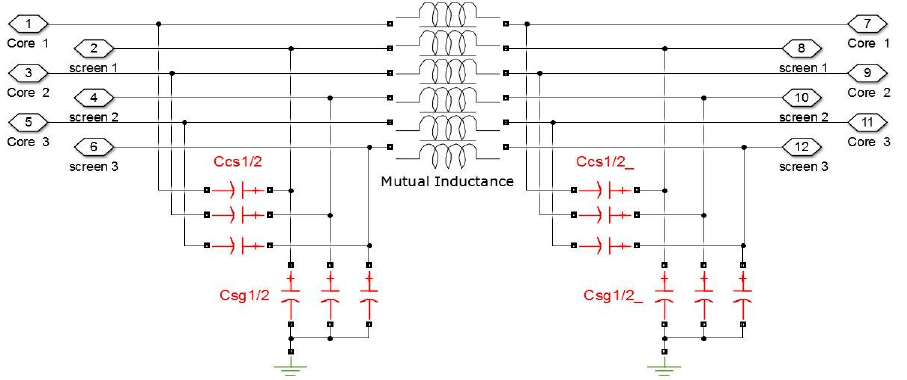
Figure A2. Model of cable power line.